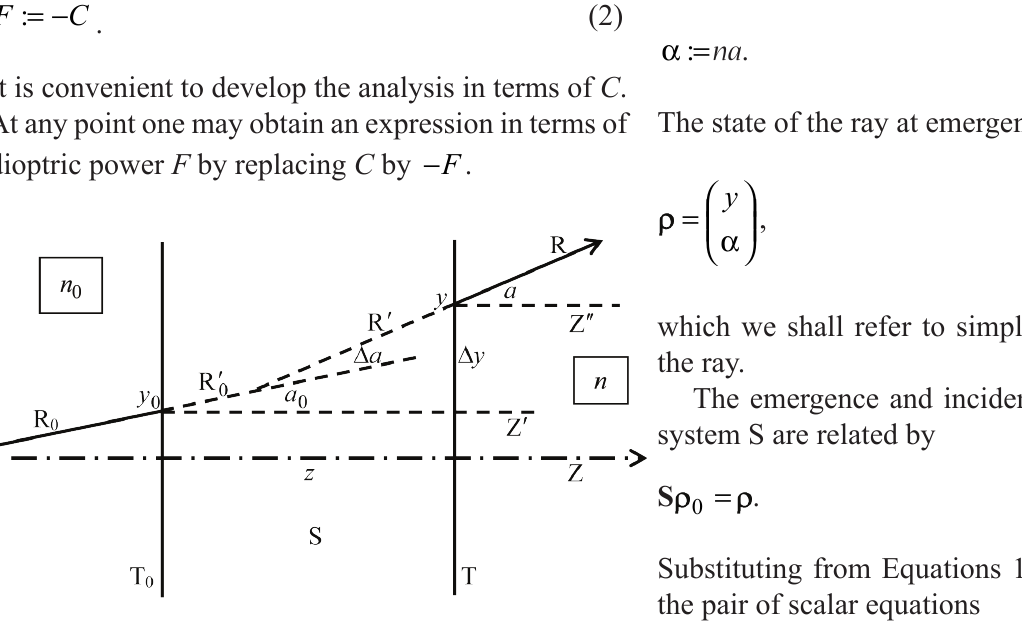
Figure 1: Deflection a ∆ and transverse translation y ∆ of a ray through an arbitrary system S in Gaussian optics (two-di- mensional). T 0 and T are transverse planes a distance z apart and orthogonal to longitudinal axis Z; they are the entrance and exit planes of S. R 0 is the incident segment of a ray. It intersects T 0 at 0 y and has inclination 0 a . R ′ is an extension of R 0 and 0 Z ′ and Z ′′ are parallel to Z. The ray emerges at T at the point y and with inclination a . 0 R ′ 0 R ′ is an extension of R. The indices of refraction immediately before and immediately after system S are 0 n and n respectively. The deflection is given by Equations 17 and 19 and the transverse translation by Equation 16 and